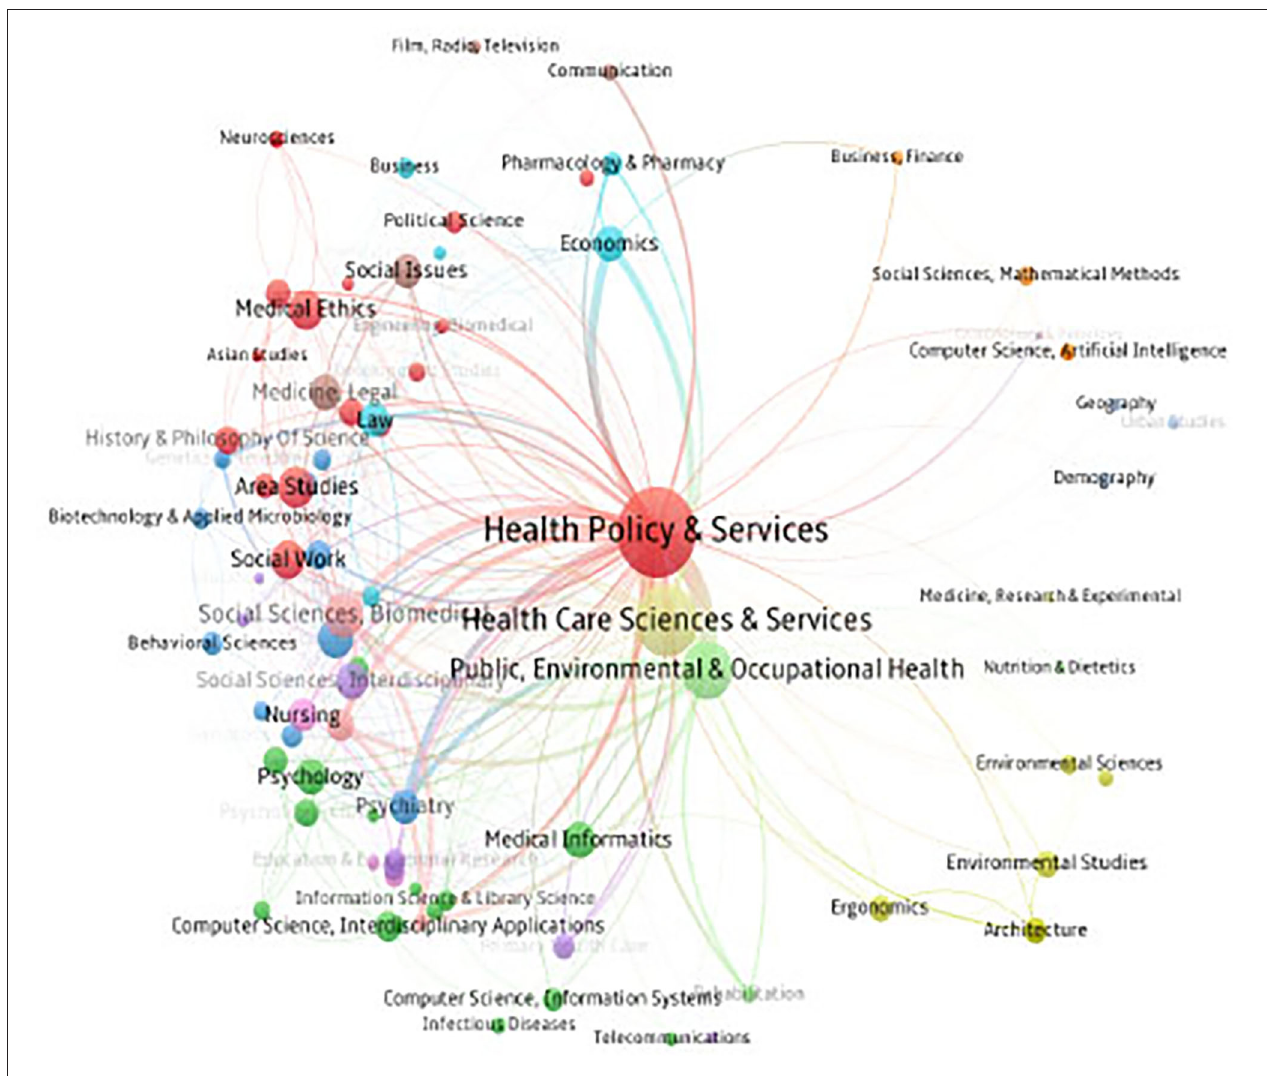
FIGURE 3 | Academic areas covered by health policy and